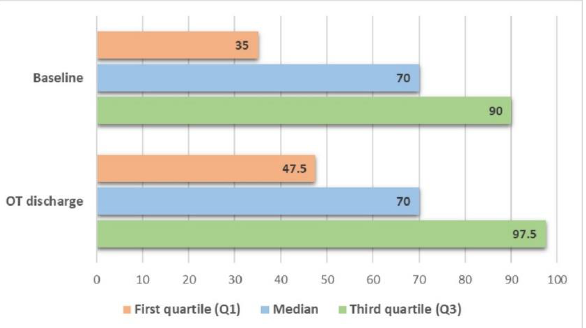
Figure 1. Functional independence, before and after the occupational therapy (OT) program ( n = 17).